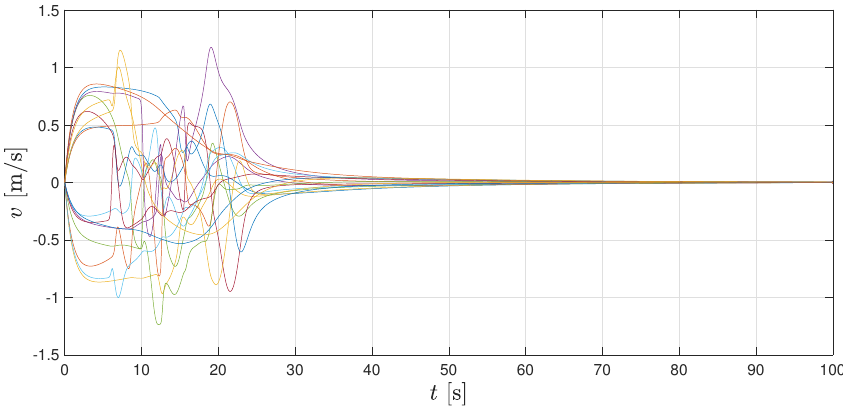
Figure 7. Velocities from 0 [s] to 100